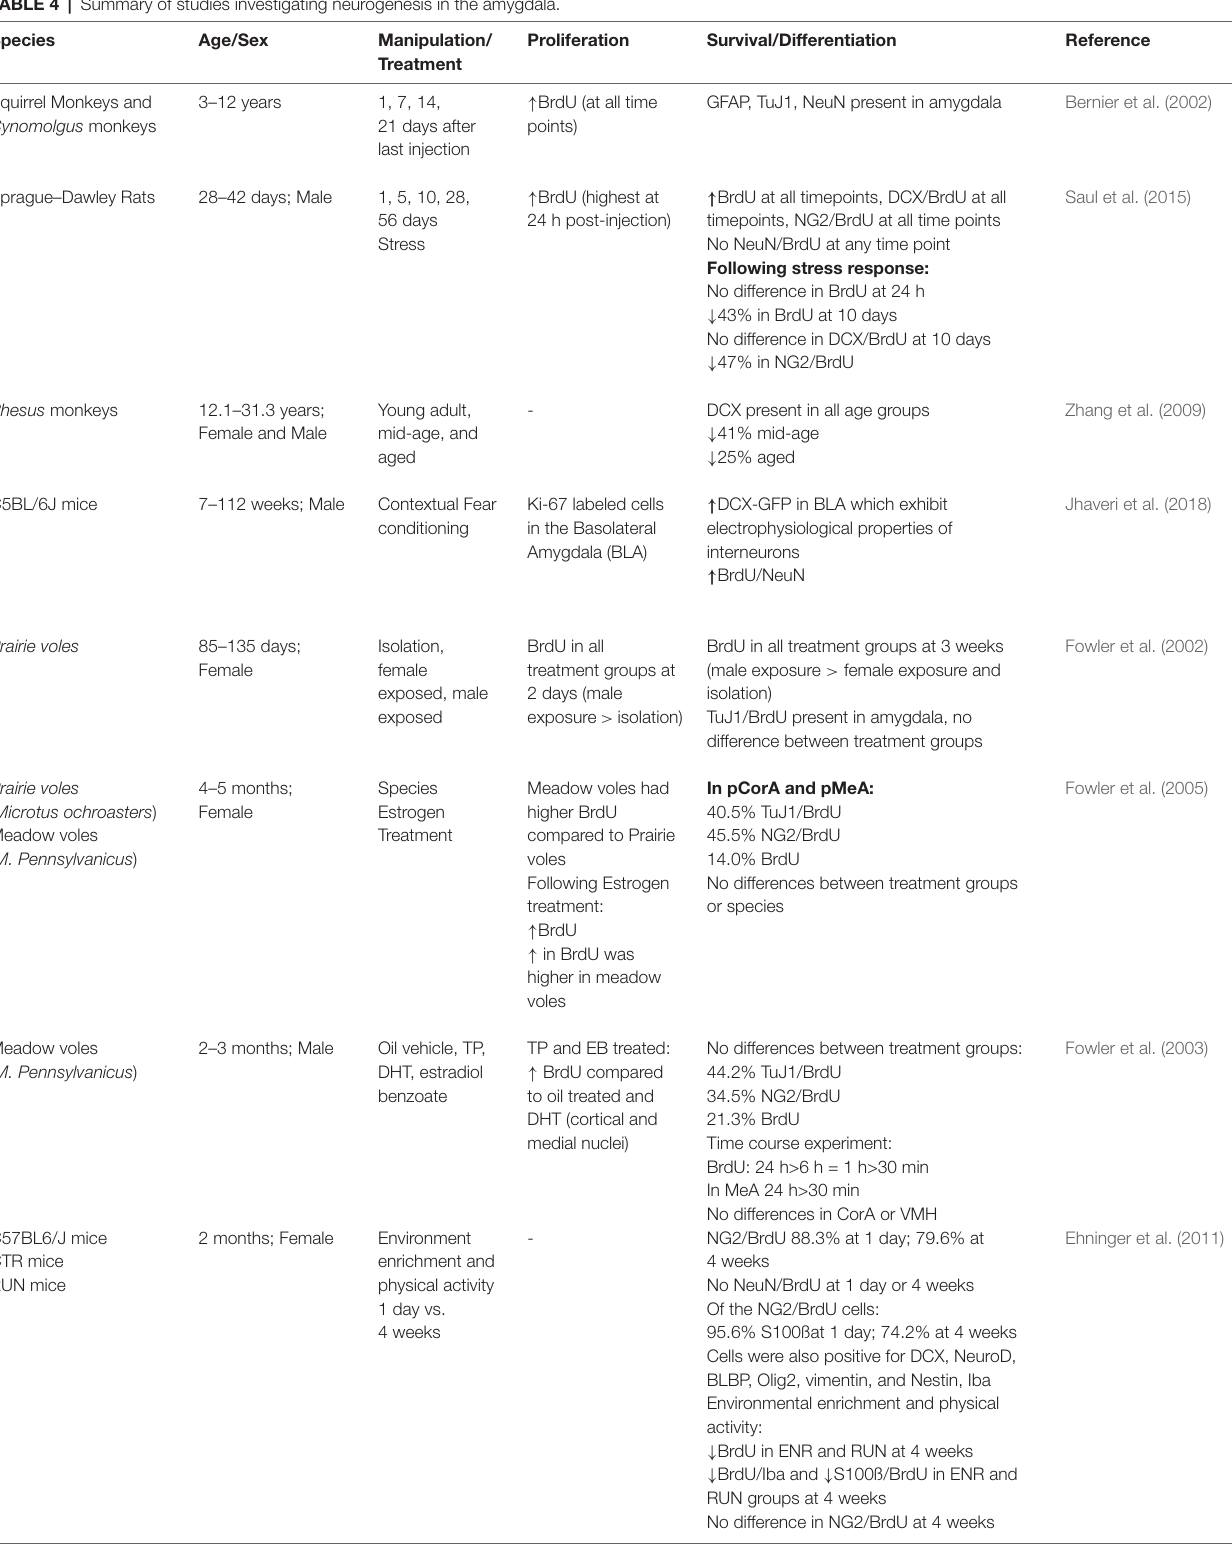
TABLE 4 | Summary of studies investigating neurogenesis in the amygdala.